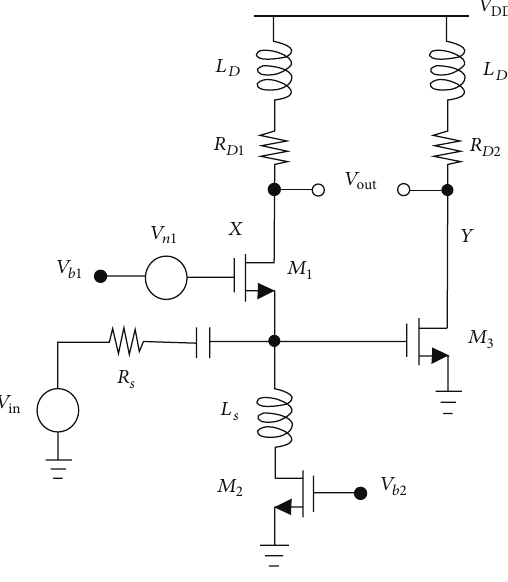
Figure 11: CG/CS stage